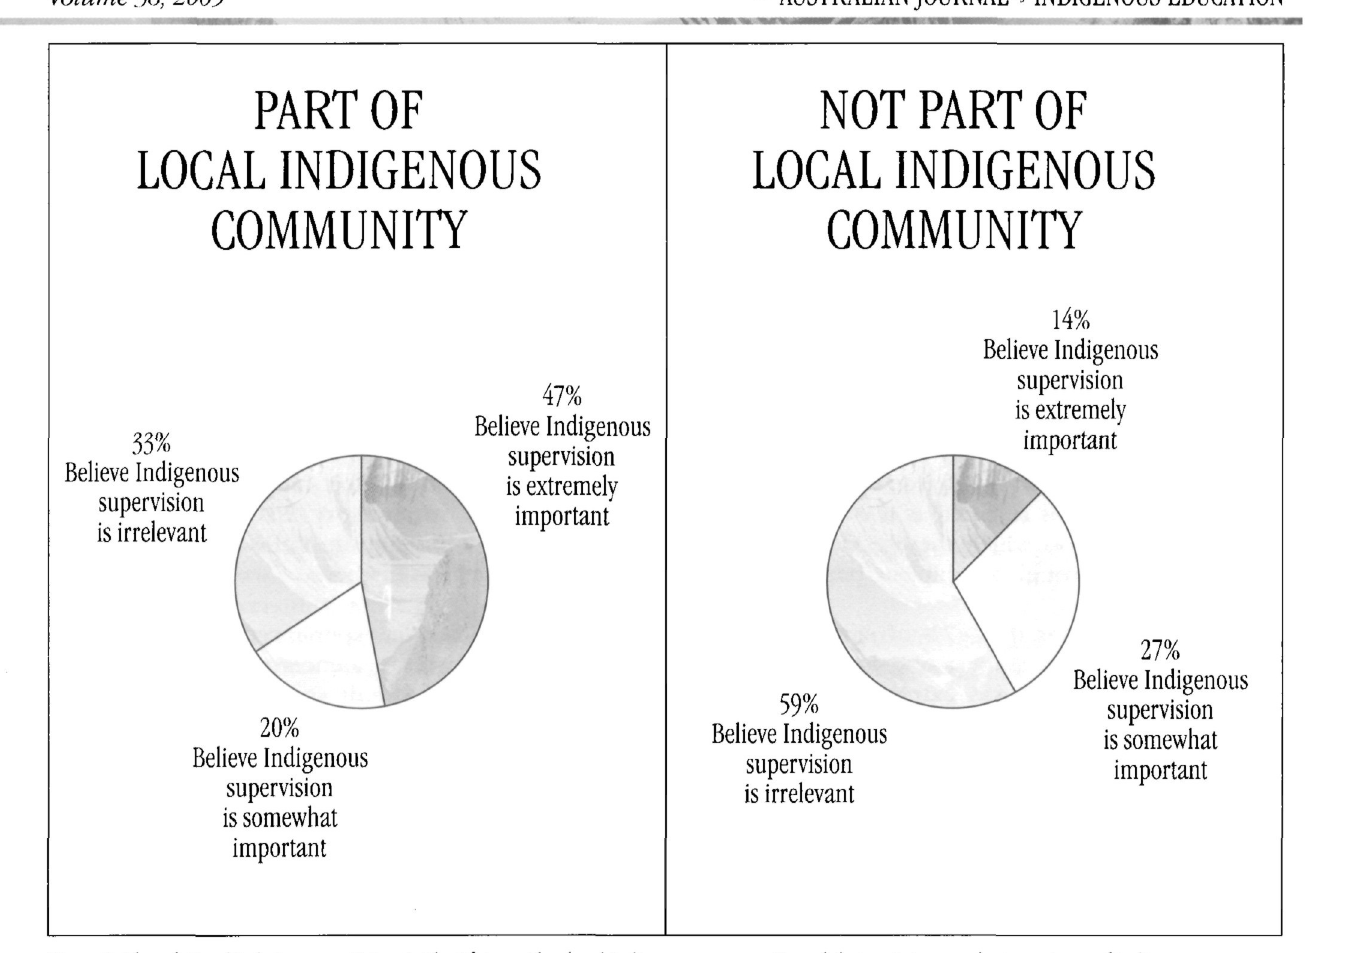
Figure 2: The relationship between participants identifying with a local Indigenous community and their opinions on the importance of Indigenous supervisors (Trudgett, 2008, p.